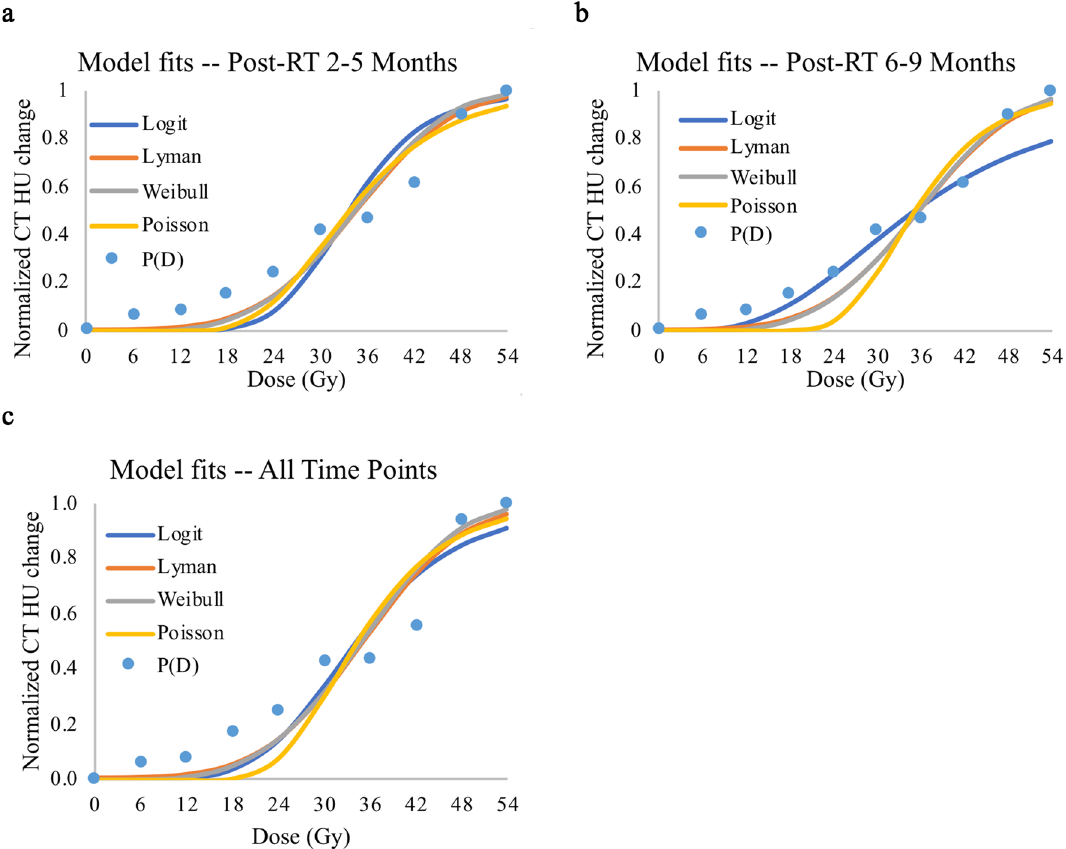
Figure 2. NTCP modeling of radiation-induced effects to the lung: dose response data and model-fits for stereotactic body radiation therapy-induced injury of the lungs. Blue dots (P(D)) represent the radiation- induced effects, defined as the cumulative change in CT HU over all associated patients, normalized from 0 to 1 based on the maximal CT HU change seen at the particular time point. Blue, orange, gray, and yellow lines represent the Logit, Lyman, Weibull, and Poisson dose response models, respectively, fit to the data points. ( a ) The data and fits of six patients at 2–5 months after radiation therapy. These time points reflect radiation pneumonitis. ( b ) The data and fits of six patients at 6–9 months after radiation therapy. These time points reflect radiation-induced lung fibrosis. ( c ) The data and fits of all 12 patient data sets over all time